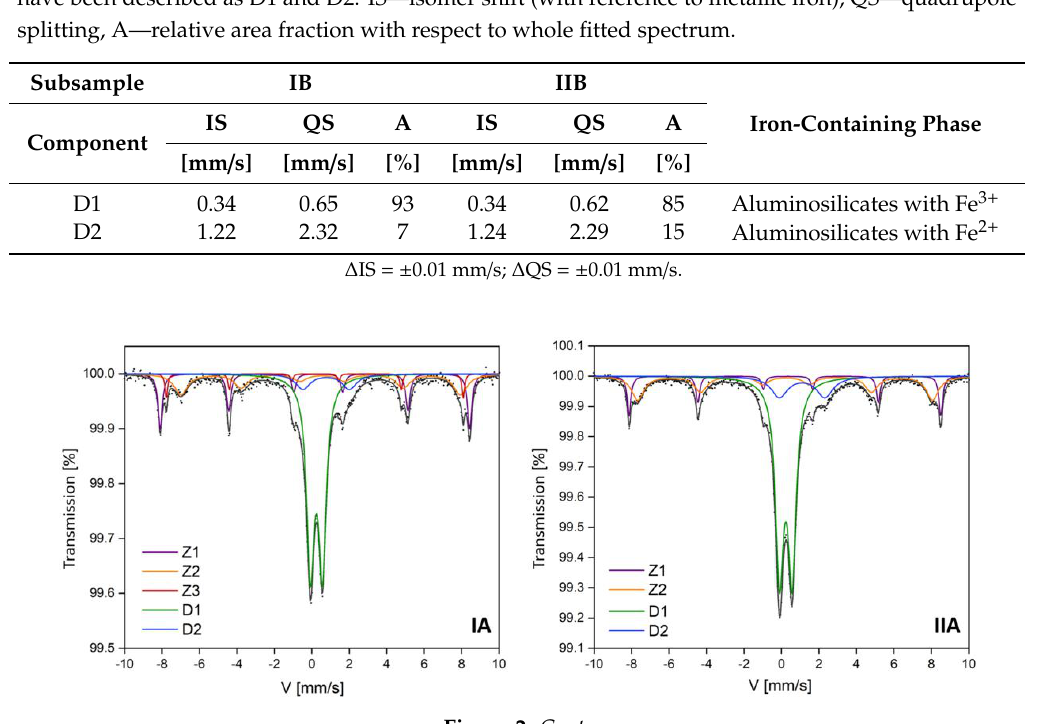
Figure 2. The room temperature Mössbauer spectra of the topsoil subsamples (IA, IIA, IB, IIB). Fitted components are presented on the figure as D1, D2, Z1, Z2, Z3. The x -axis of these charts represents velocity (V), while the y -axis represents transmission (%). G—full width at half maximum = (0.35–0.40) mm/s . Hyperfine parameters for D1 components may be disturbed by the overlapping of parameters characteristic for magnetite and maghemite nanoparticles, ferrihydrite, or pyrite, the presence of which was not found in the XRD analysis. However, their presence cannot be excluded by analyzing the results contained in the paper of Stevens et al. [25]. The differences between hyperfine parameters for the identified aluminosilicates can also be related to the differences in the chemical composition (iron content, as confirmed by chemical analysis carried out with the SEM-EDS method) of the identified components, which were determined by the ionic forms of iron in these compounds. The spectra of IB and IIB subsamples do not have a magnetic component (no sextet) [33]. This is in agreement with the X-ray diffraction results that revealed the presence of muscovite (M1) and orthoclase (O1), which presumably correspond to aluminosilicates identified by Mössbauer spectra. The proportion of aluminosilicate hydroxide with Fe 2+ doublet (D2) revealed various dependencies. The magnetic fraction did not influence its content in investigated samples, but the share of D2 component in the coarse granulometric fraction was twice as high as in the smaller one. The percentage of D2 component in iron-containing phase composition of IA and IB (0.05–0.10 mm) was up to 8%, while for IIA and IIB (0.25–0.50 mm) it was up to 15%. The experimental spectra of strongly magnetic subsamples (IA and IIA) were fitted by Zeeman sextets (Z1, Z2, and Z3). The Z1 component with a hyperfine magnetic field value of 51 T was identified as hematite with a stable share in the sample (19%). Similar results of Mössbauer spectroscopy were obtained for fly and bottom ashes generated in fluidized bed boilers in a Silesian power plant [34]. In fly ash samples, Waanders et al. found the presence of hematite and compounds with Fe 3+ ions, as well as amorphous Fe 3+ , in glass and muscovite [35]. The similarities in hyperfine parameters with results obtained in the presented work suggest that fly ashes may be a source of pollution in the studied soils. Hematite could be the product of oxidative pyrolysis of the Fe- sulphates and carbonates, but also it can arise during the dehydroxylation of goethite and lepidocrocite [36].